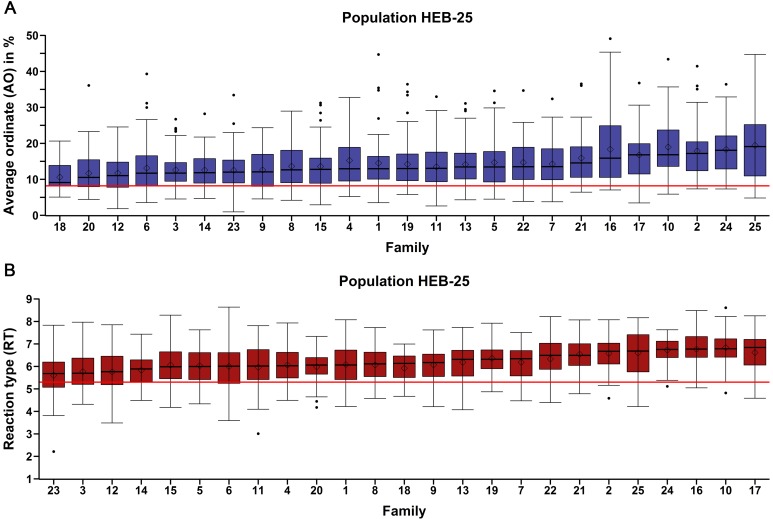
Box-whisker plots per HEB family indicating the variation in genotype responses to net blotch infection.(A) average ordinate (AO) and (B) reaction type (RT). The y-axis shows the data for each trait; the x-axis depicts the 25 families of HEB-25 (1–25) sorted by ascending median. The red line depicts the value of the resistant check for the respective trait.